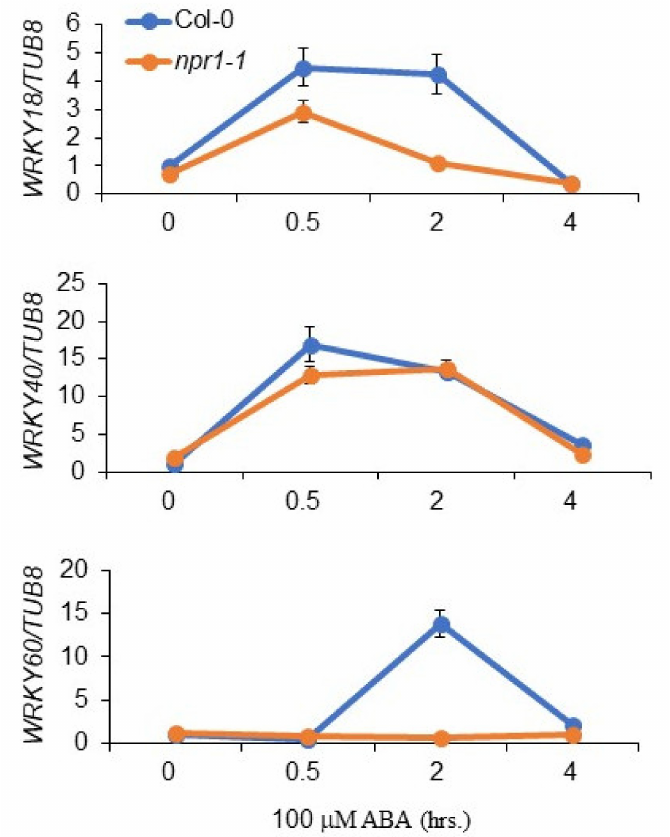
Figure 5. NPR1 regulates WRKY gene expression in an ABA-dependent manner. The abundance of WRKY transcripts in npr1-1 plants under ABA stress defines their ABA-insensitive phenotype. The expression of WRKY genes in Col-0 and npr1-1 strains. Seeds of wild-type (Col-0) and npr1-1 plants were cultured on 1/2 MS medium for 2 weeks and then treated with 100 µ M ABA for the indicated durations (0, 30 min, 2 h, and 4 h). Total RNA was extracted from the seedlings and analyzed using RT-qPCR. TUB8 was used as an internal control. The error bars indicate